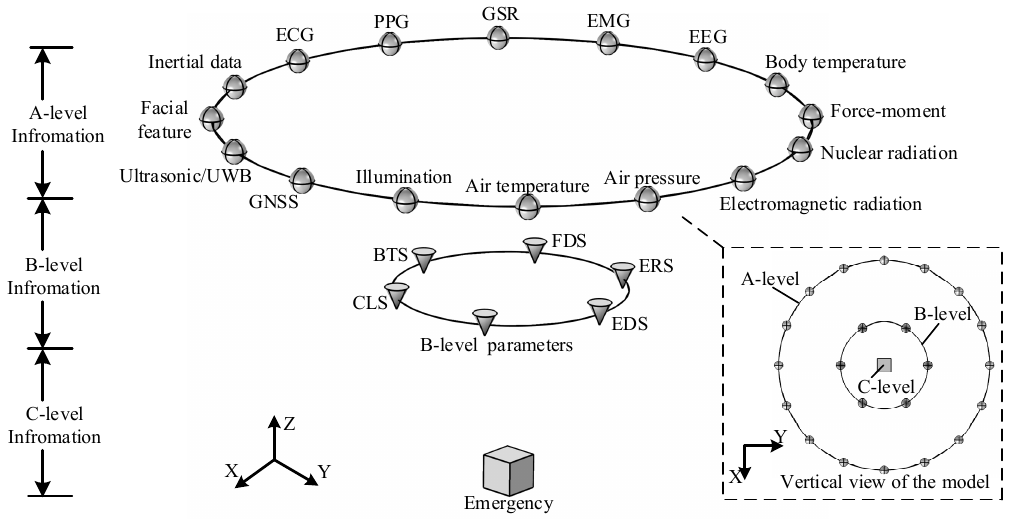
Figure 1. The multi-level fusion framework.